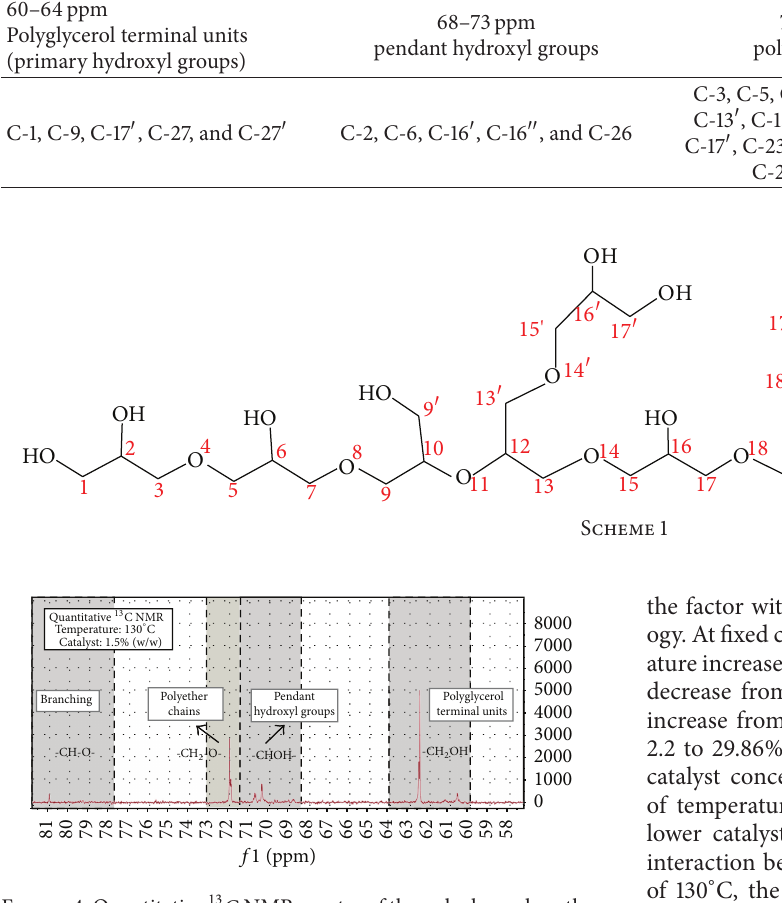
Figure 4: Quantitative 13 C NMR spectra of the polyglycerol synthe- sized at 130 ∘ C and 1.5% (w/w) catalyst